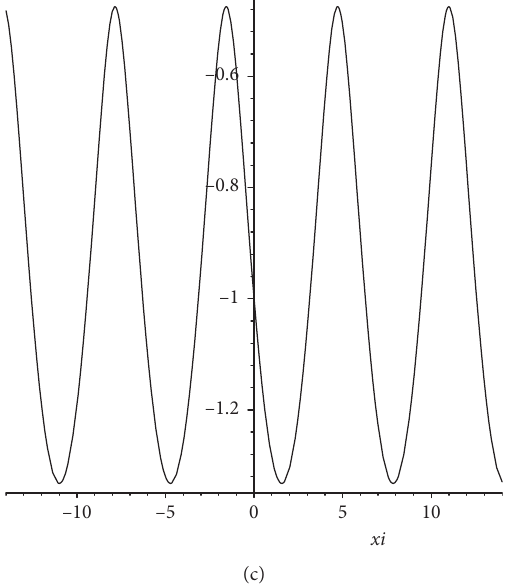
Figure 7: When c � 1 ,g � − 1, profiles of smooth periodic solutions for h � 0 (a) and h � 0 . 1 (b, c),